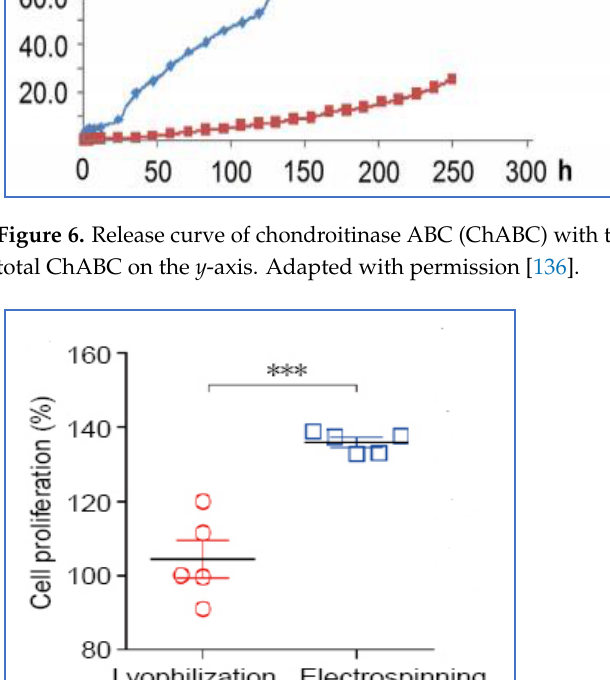
Figure 6. Release curve of chondroitinase ABC (ChABC) with the number of hours on the x -axis and total ChABC on the y -axis. Adapted with permission [136].